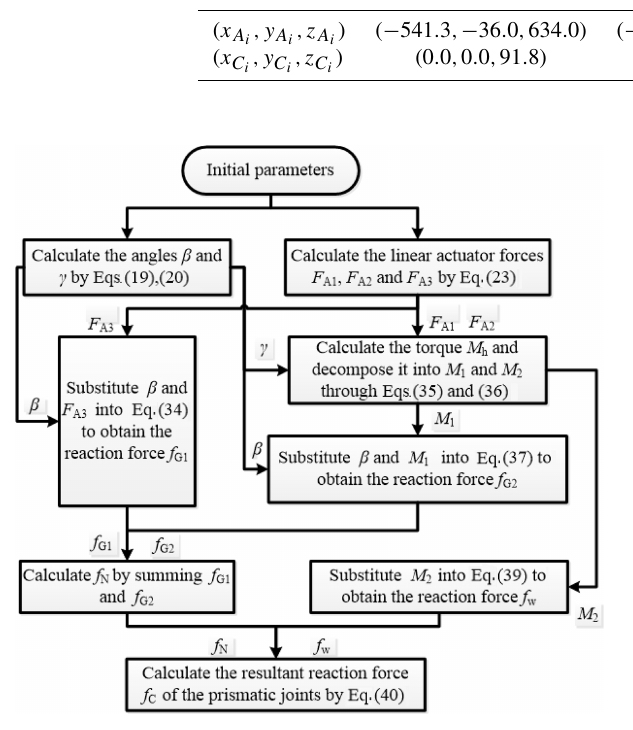
Figure 9. Calculation procedure for the reaction forces of the pris- matic